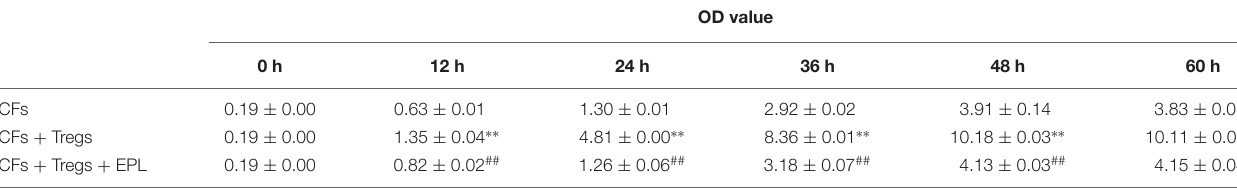
TABLE 2 | The proliferation of CFs over the time curve stimulated by Tregs in co-incubation by CCK-8 assay ( ¯ x ± s , n = 8).